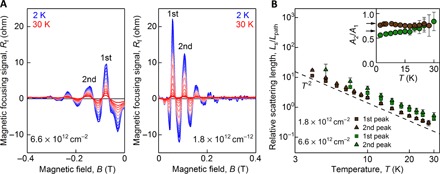
Temperature dependence of magnetic focusing.(A) Temperature dependence of the TMF signal measured at two characteristic carrier densities for device D1 (see legends). T was varied from 2 to 30 K (blue to red). (B) T dependence of the relative scattering length (see text) extracted from experimental data for consecutive focusing peaks. Absolute scattering lengths for several relative orientations of the crystallographic axes and the sample edge are shown in fig. S6. Dashed line shows T−2 dependence. The inset shows the ratio of the areas under the first and second focusing peaks in (A) as a function of T. Arrows correspond to A2/A1 = 0.8 and 0.65 (see text). Error bars indicate the accuracy of determining A2/A1; large errors at T > 20 K are due to the relatively large background signal as the focusing peaks become strongly suppressed.